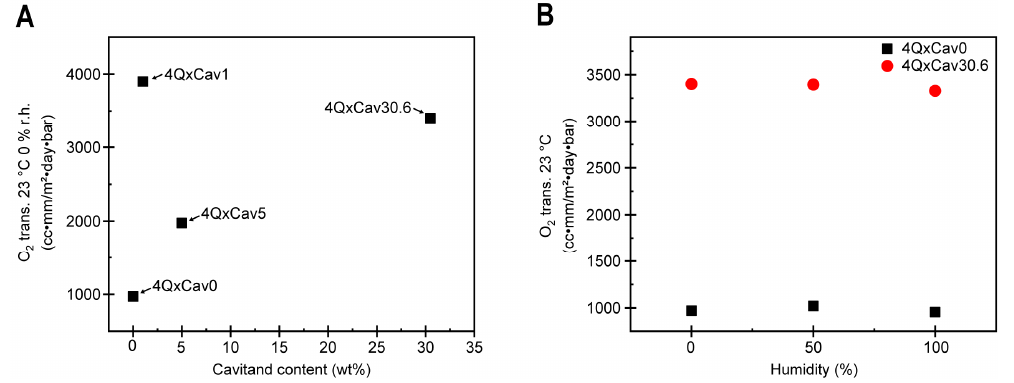
Figure 6. A : Oxygen transmission rates of pristine and velcrand functionalized PE-HEMA as a function of velcrand content in wt% (0, 1, 5, and 30.6 wt%). B : Influence of humidity on oxygen transmission of pristine and functional PE-HEMA.